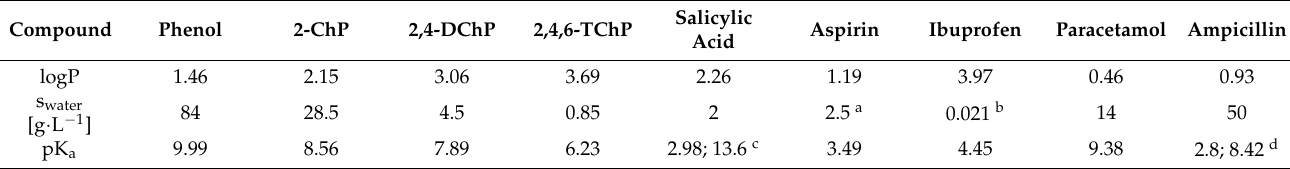
Table 6. Properties of the adsorbates [57].